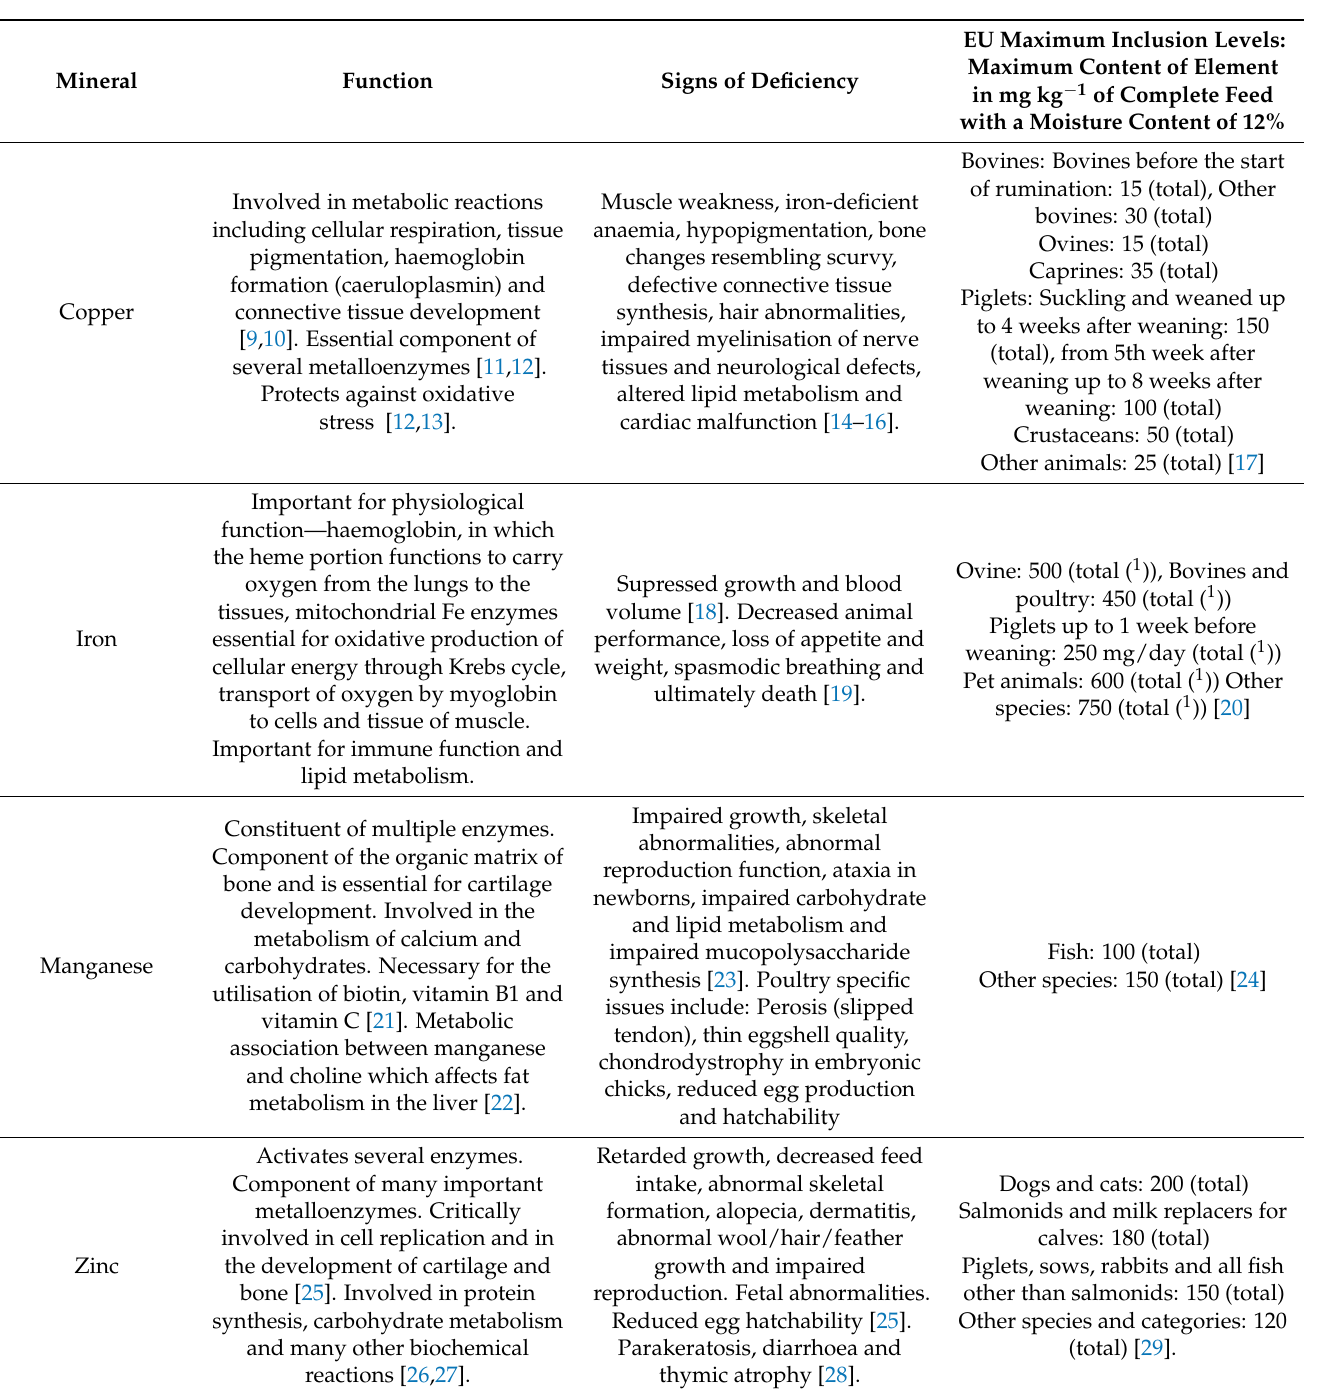
Table 1. Primary functions and inclusion levels of selected trace minerals and signs of